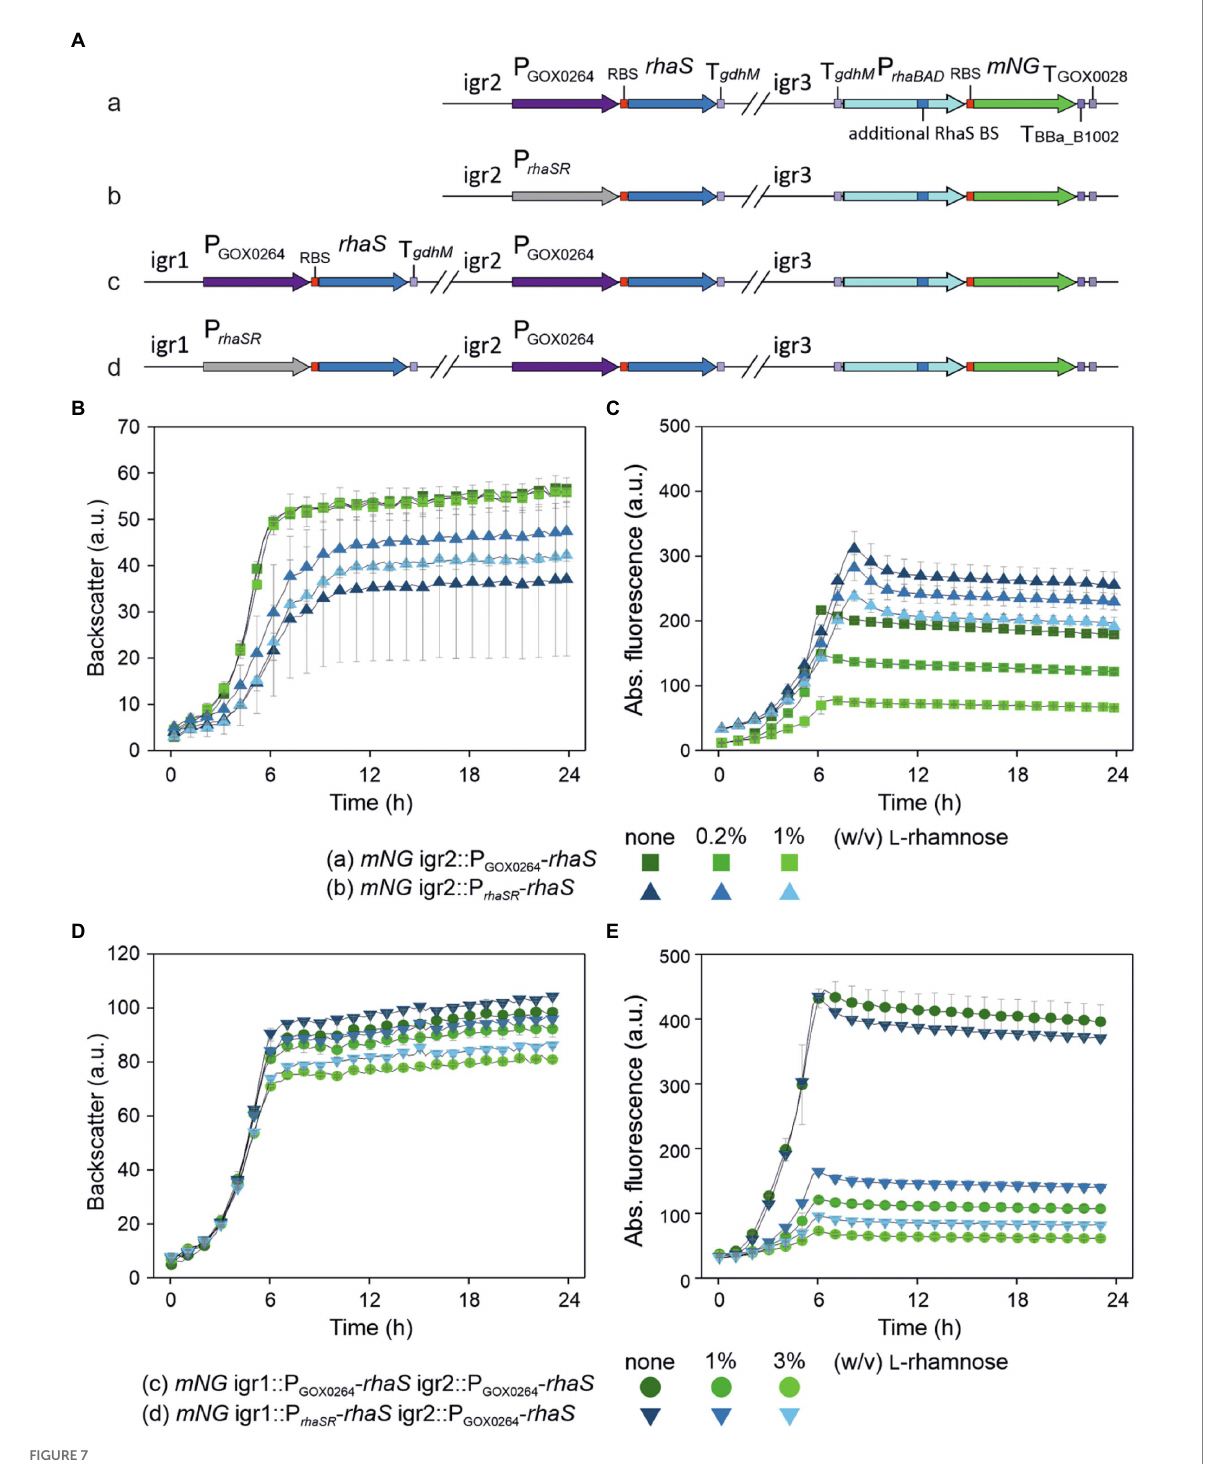
FIGURE 7 Partial repression of genomic single-copy P rhaBAD (+RhaS-BS) - mNG using genomically integrated copies of rhaS . (A) Schematic illustration of the genomic backgrounds of the G. oxydans 621H strains. The expression cassette P rhaBAD (+RhaS-BS) - mNG of the reporter gene was genomically integrated into the intergenic region igr3 (GOX0038/GOX_RS01330–GOX0039/GOX_RS01335). The resulting strain was termed G. oxydans mNG . For single-copy rhaS expression, a rhaS expression cassette either under control of P GOX0264 (a) or P rhaSR (b) was genomically integrated in G. oxydans mNG into igr2 (GOX0028/GOX_RS01280 - GOX0029/GOX_RS01285). A second rhaS expression cassette again either under control of P GOX0264 (c) or P rhaSR (d) was genomically integrated into igr1 (GOX0013/GOX_RS01200 - GOX0014/GOX_RS01205) in strain A with P GOX0264 - rhaS in igr2. (B,D) Growth of the strains in d -mannitol medium according to backscatter and (C,E) absolute mNG fluorescence in BioLector cultivations. l -Rhamnose was supplemented as indicated. All data represent mean values and standard deviation from two biological replicates (clones) with three technical replicates each. BioLector settings: backscatter gain 20, fluorescence gain